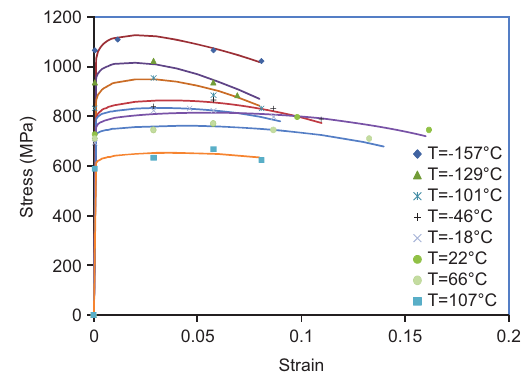
Figure 4 Change of softening coeffi cient B strain rate.